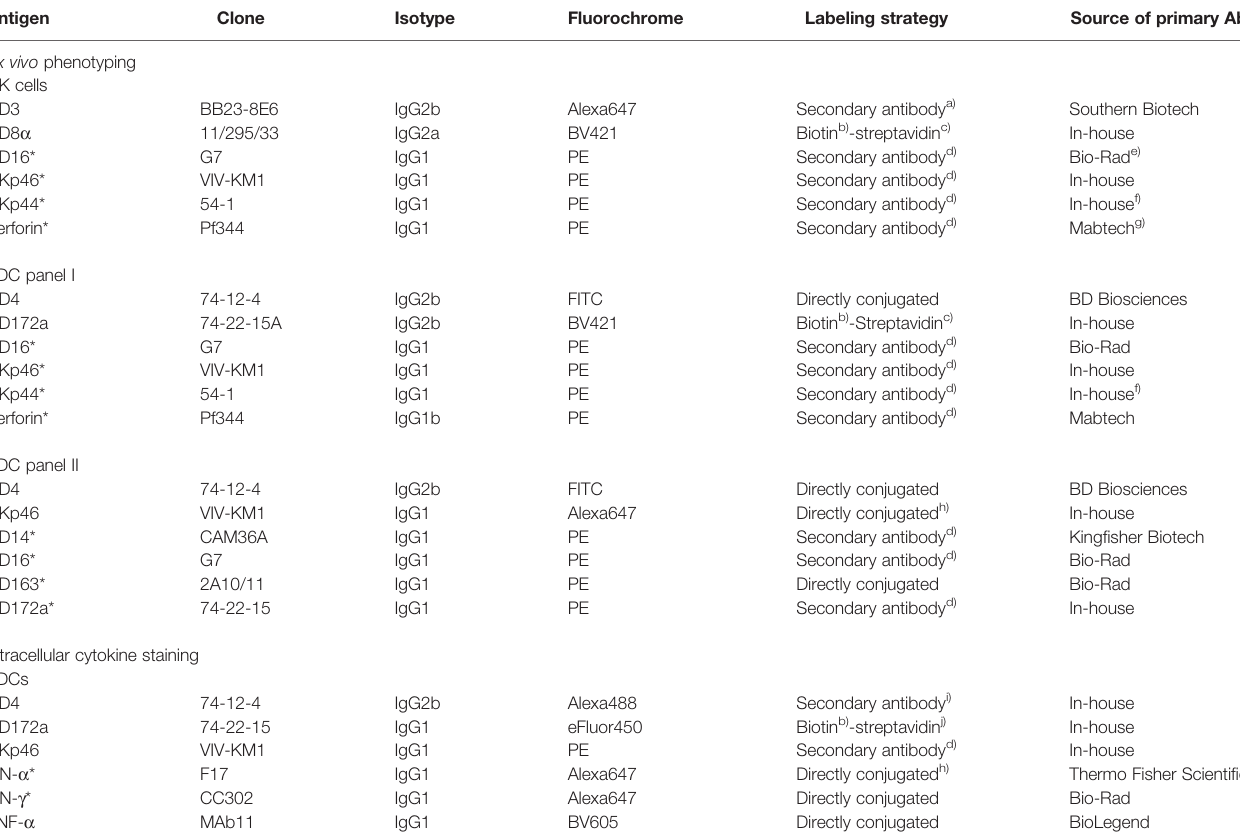
TABLE 2 | Primary antibodies and secondary reagents used for FCM